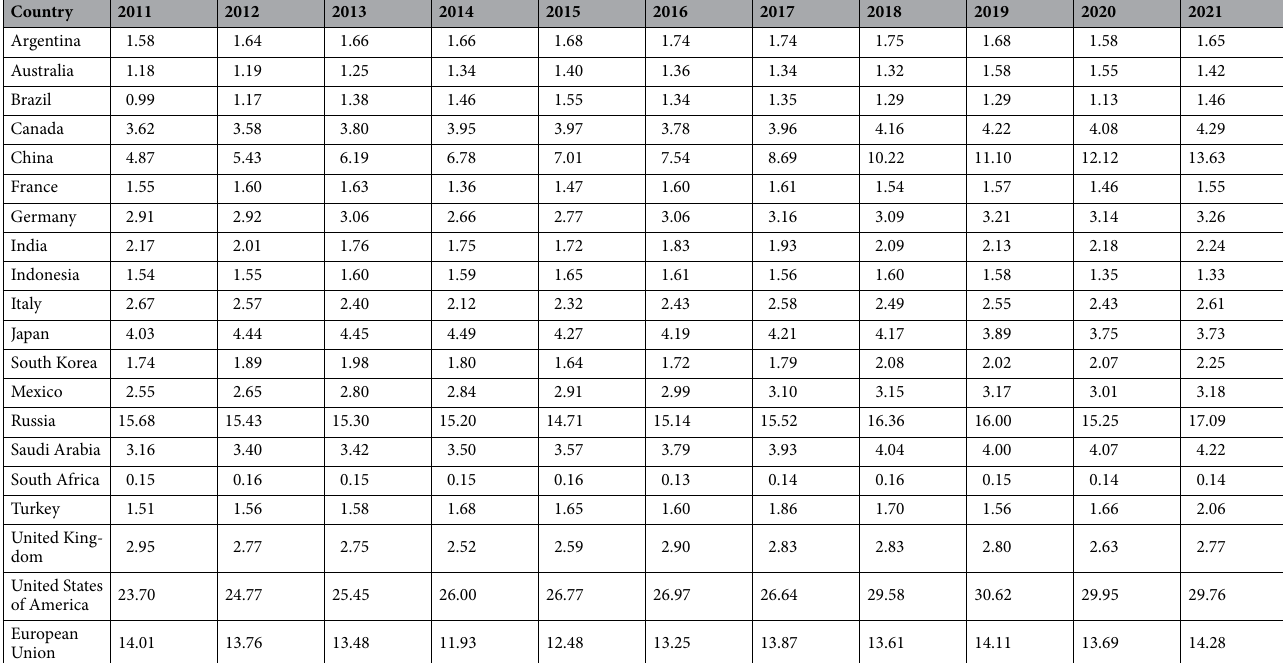
Table 6. Natural gas consumption data of G20 countries 47 . All consumption in